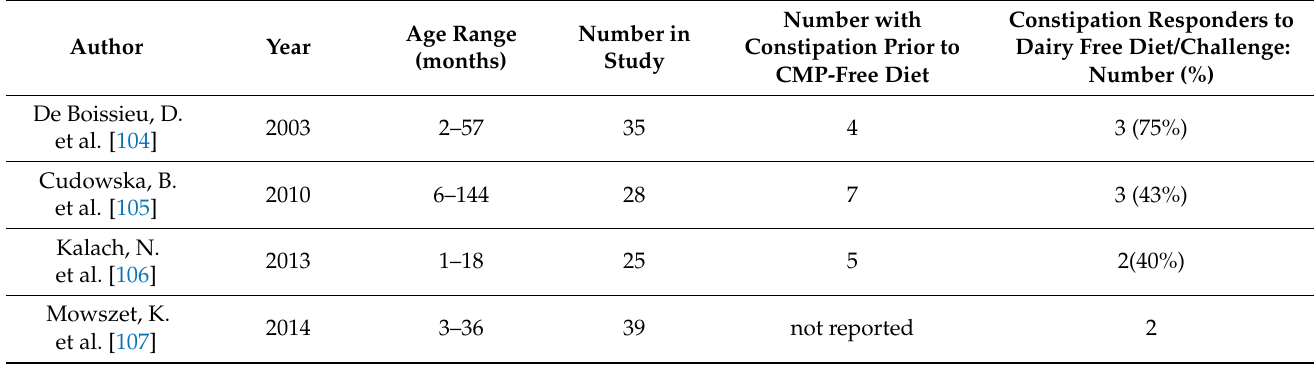
Table 2. Studies on investigations for detection of cows’ milk allergy in which constipation was reported by some